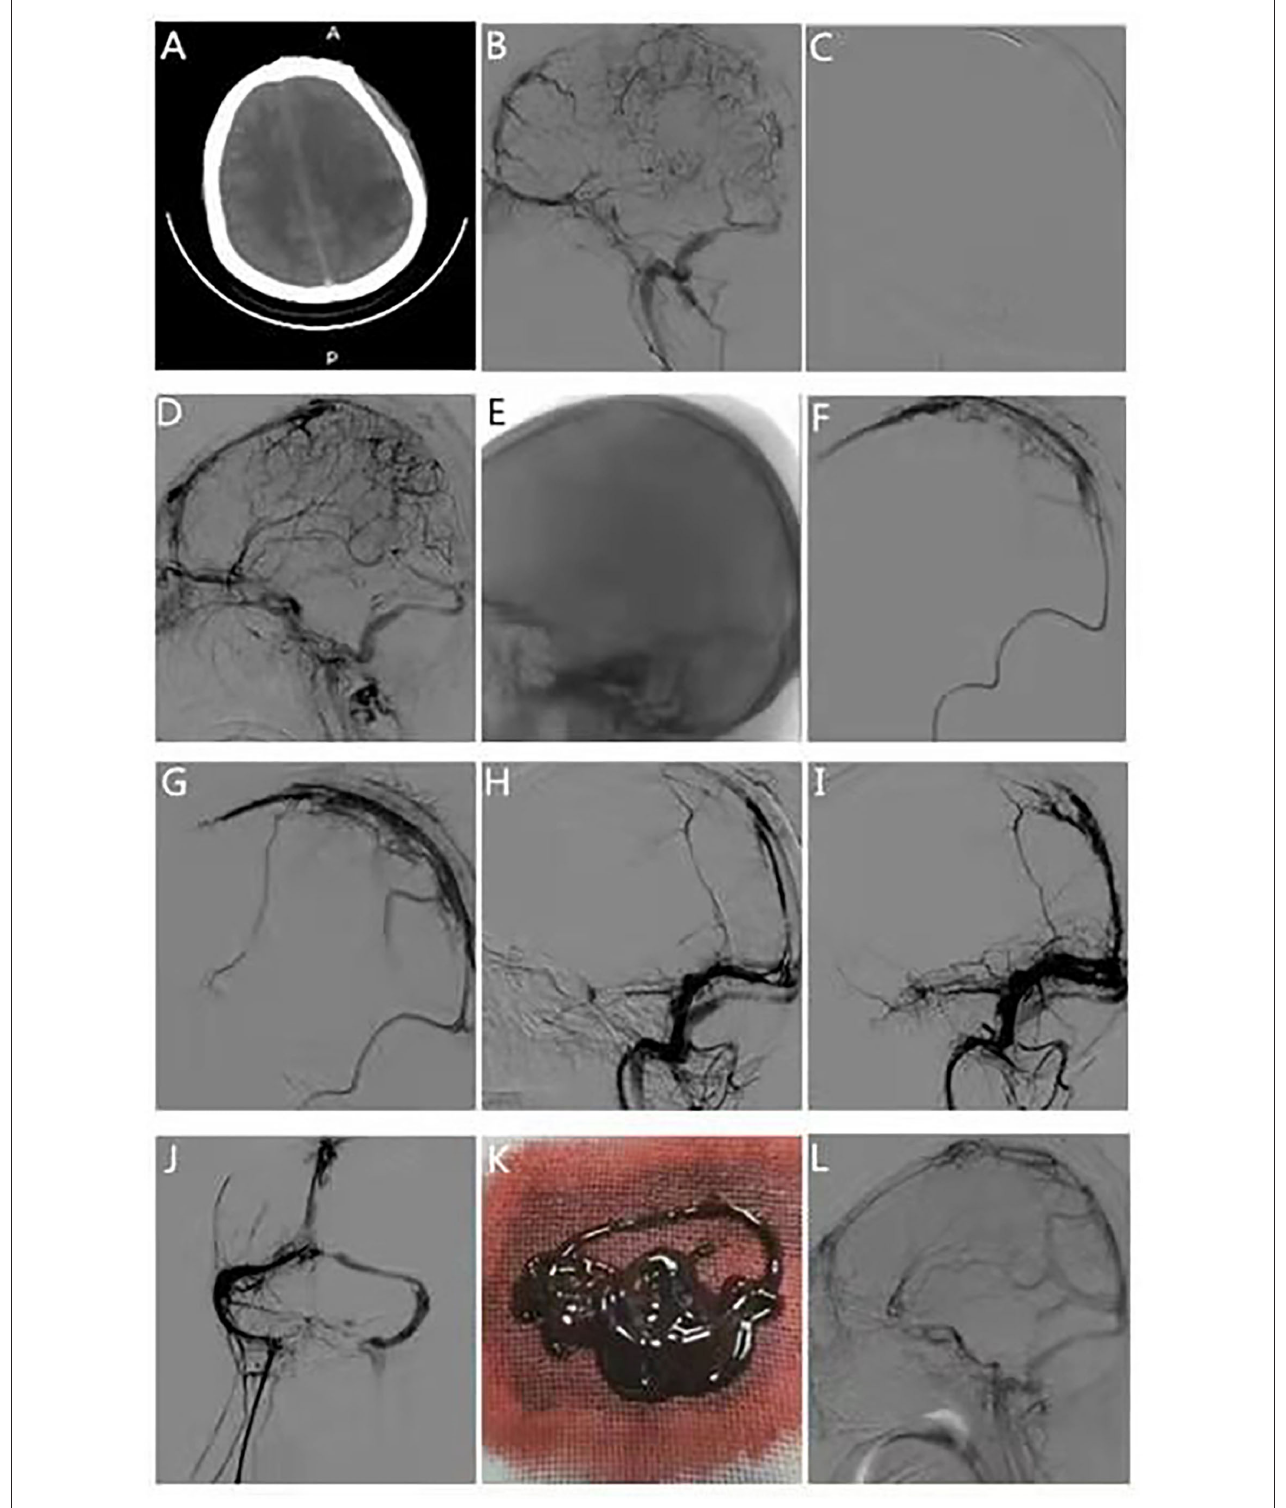
FIGURE 2 | Typical case 2. The patient was a 29-year-old woman transferred from the outside hospital due to sudden headache, hemiparesis, coma, and limb twitching for 1 day. (A) Computed tomography scan of the head on admission suggests left parietal hemorrhage. (B) DSA suggests occlusion of the superior